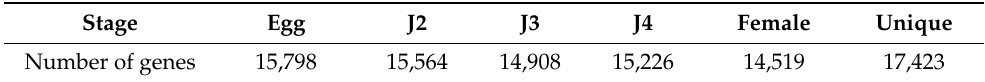
Table 2. Stage-wise distribution of M. incognita mRNA gene expression. The number of genes expressed at each stage is based on the threshold of FPKM ≥ 0.3.